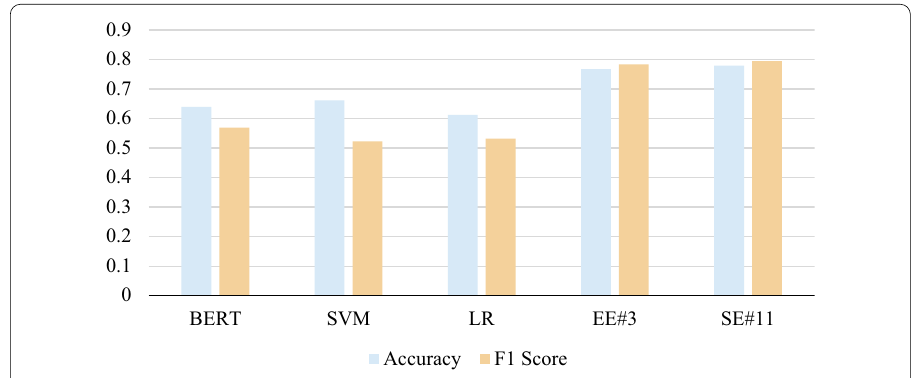
Fig. 8 Performance comparison between baseline models and two best scenarios (EE#3 and